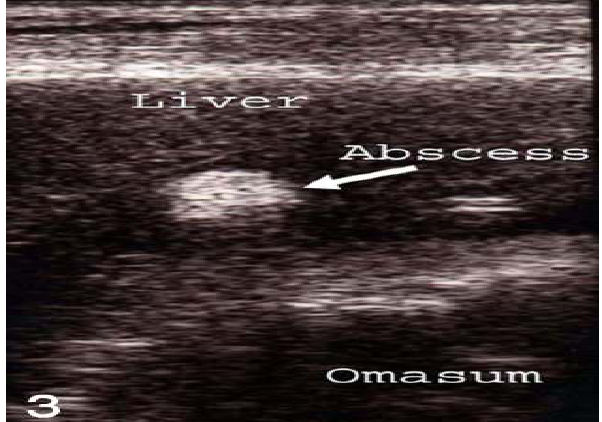
pinpoint, echogenic structure represent minute abscesses while liver appears as hypoechoic structure.